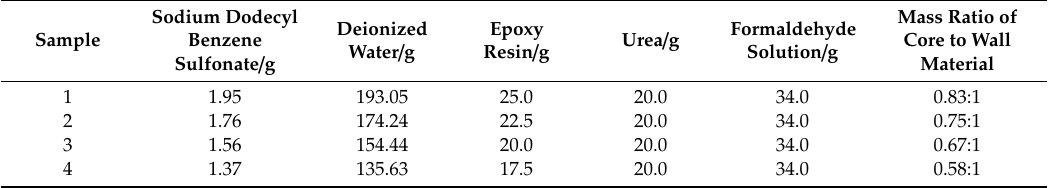
Table 1. A detailed list of the amount of material for microcapsules.